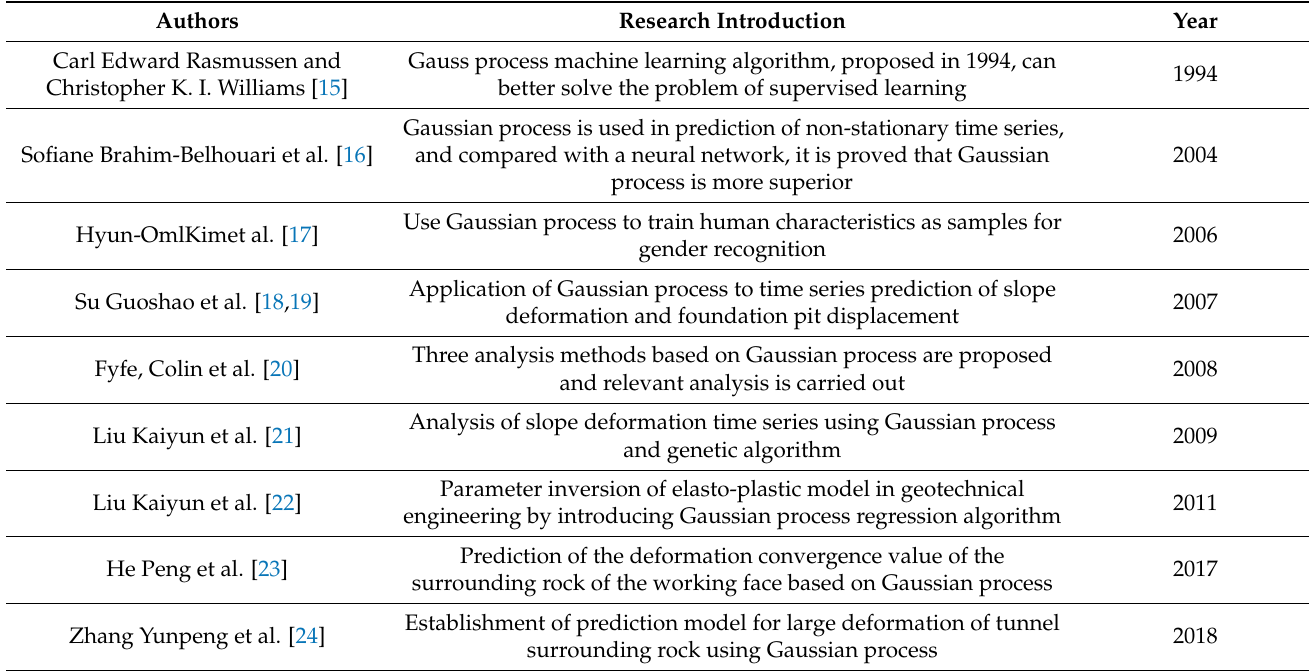
Table 1. Application research of Gaussian process machine learning